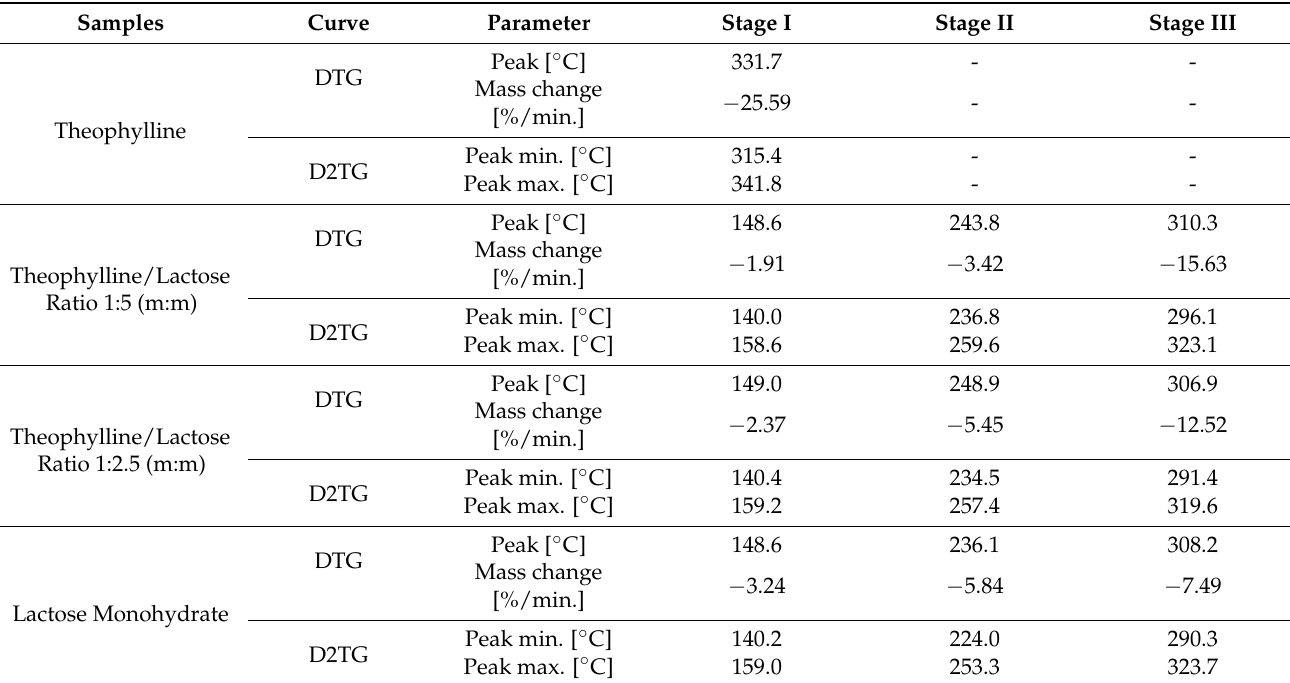
Table 5. Characteristic parameters of DTG, and D2TG curves of the tested